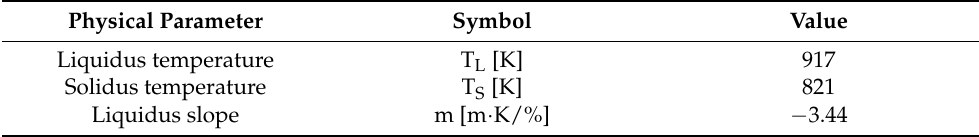
Table 1. Physical property parameters of Al-4.7% Cu